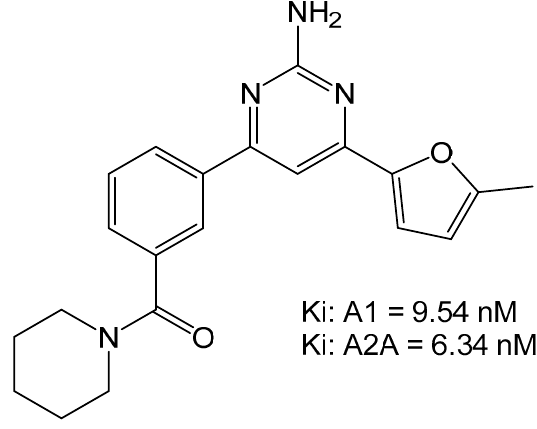
Figure 9. Structure of the 2-amiopyridine that was found to be a dual A 1 /A 2A receptor [33].